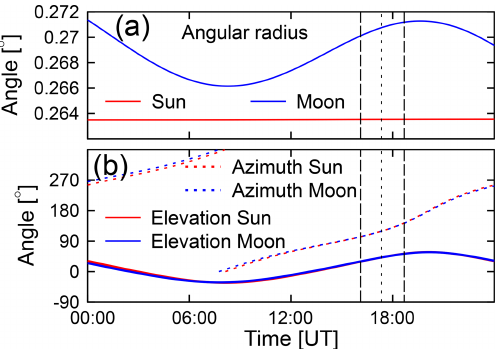
Figure 5. (a) Apparent angular radii of Sun and Moon on 21 Au- gust 2017. The apparent radius of the Sun is virtually constant over time, while the radius of the Moon varies considerably during the day due to the rotation of the Earth, which changes the distance between two hypothetical observers standing on the Earth and the Moon. (b) Corresponding solar and lunar elevation and azimuth an- gles. Note the conversion of the curves at the time of maximum eclipse (short-dashed vertical line). Long-dashed lines indicate the times of the first and fourth